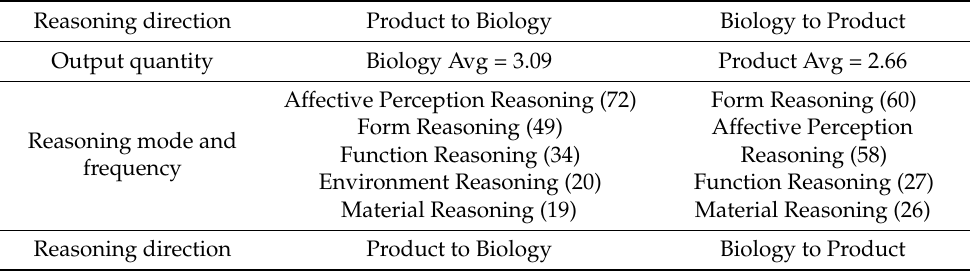
Table 10. Comparison of biology-to-product and product-to-biology reasoning models.